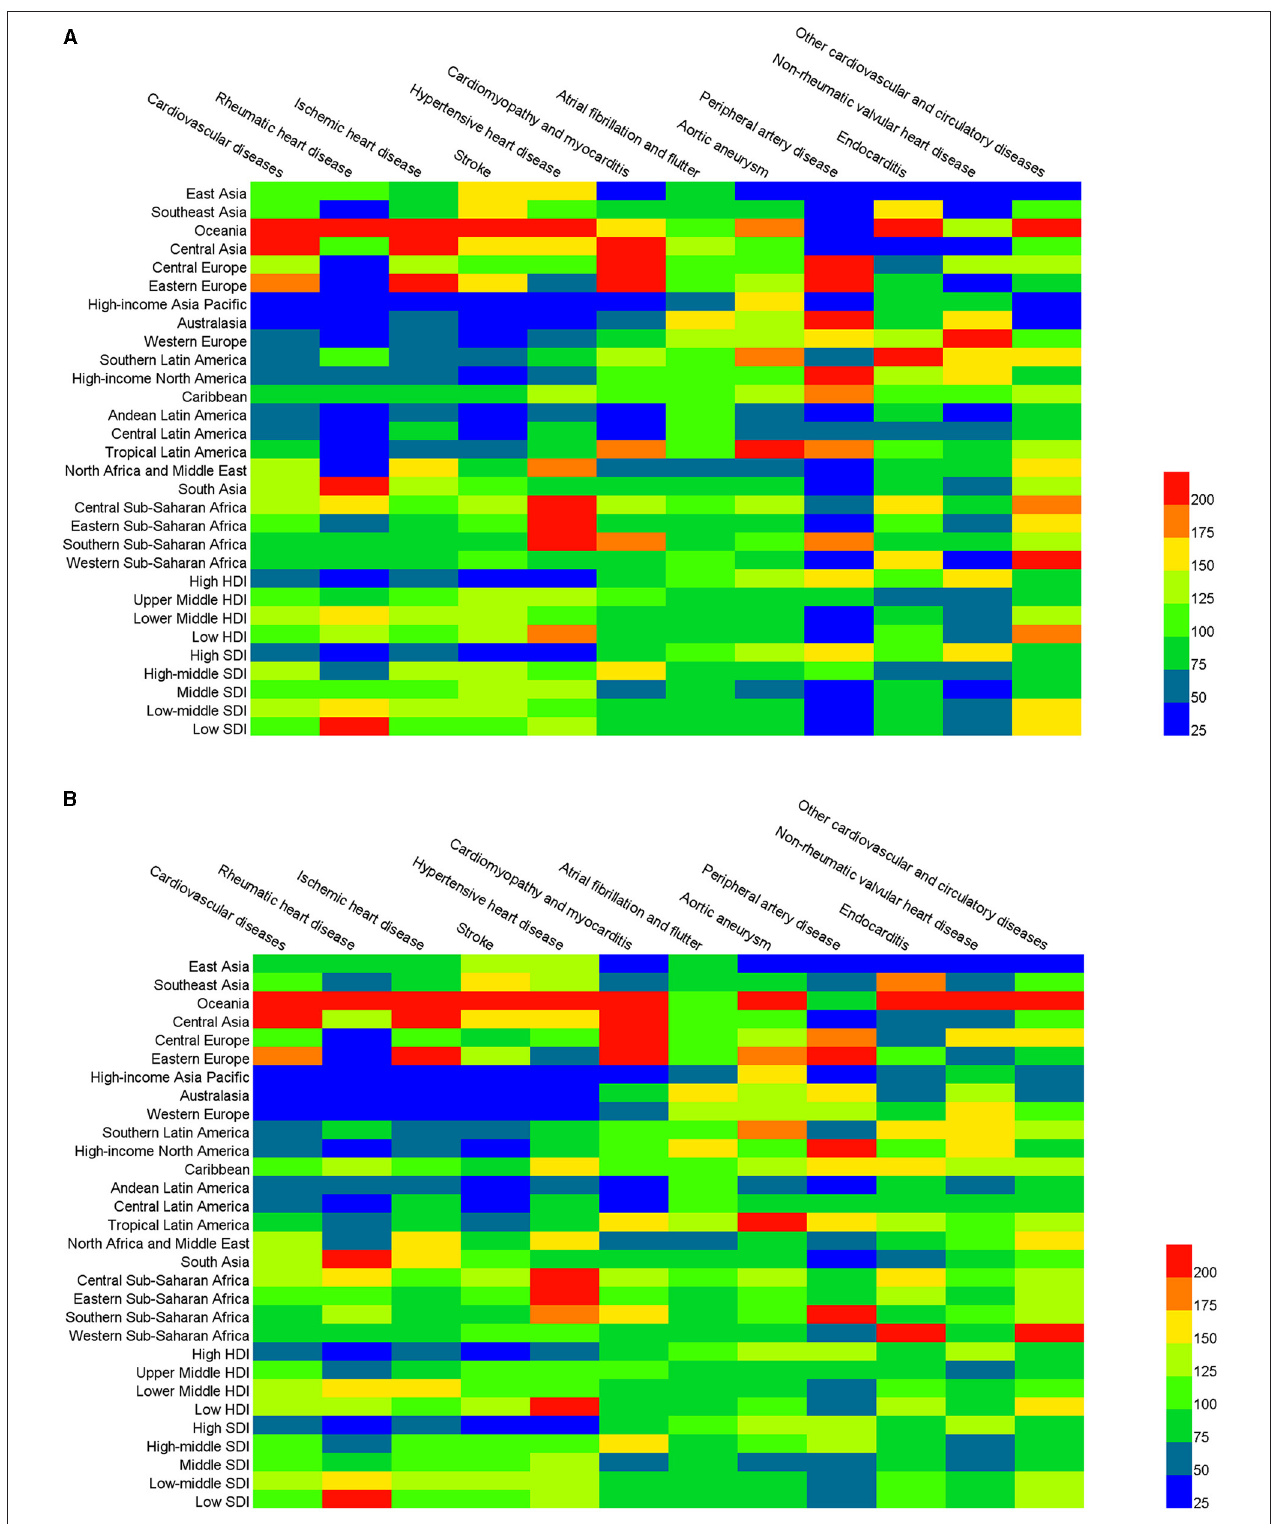
FIGURE 4 | The age-standardized death rate (ASDR) (A) and age-standardized DALYs rate (ASRY) (B) of CVD and its 11 categories for 21 regions, human development index (HDI), and sociodemographic index (SDI) regions compared with the global in 2017.